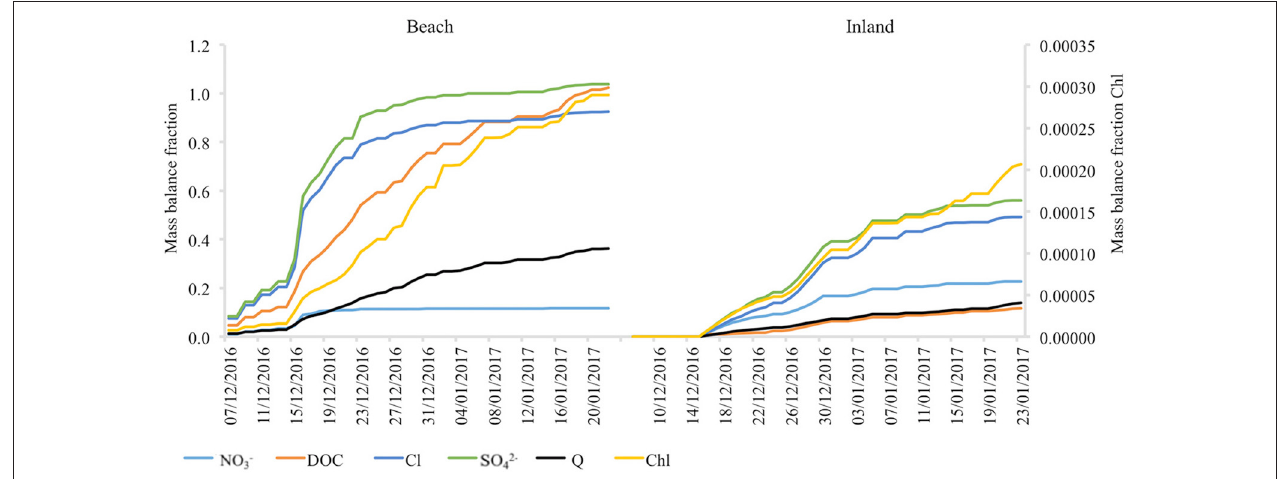
FIGURE 10 | Ratio of cumulative export of species to initial snowpack loading at the beach site and at the inland site. Values of 1 represent the total export by meltwater matching the total initial snowpack loading. Values below 1 suggest assimilation or retention within the snowpack, while values above 1 indicate that production must have